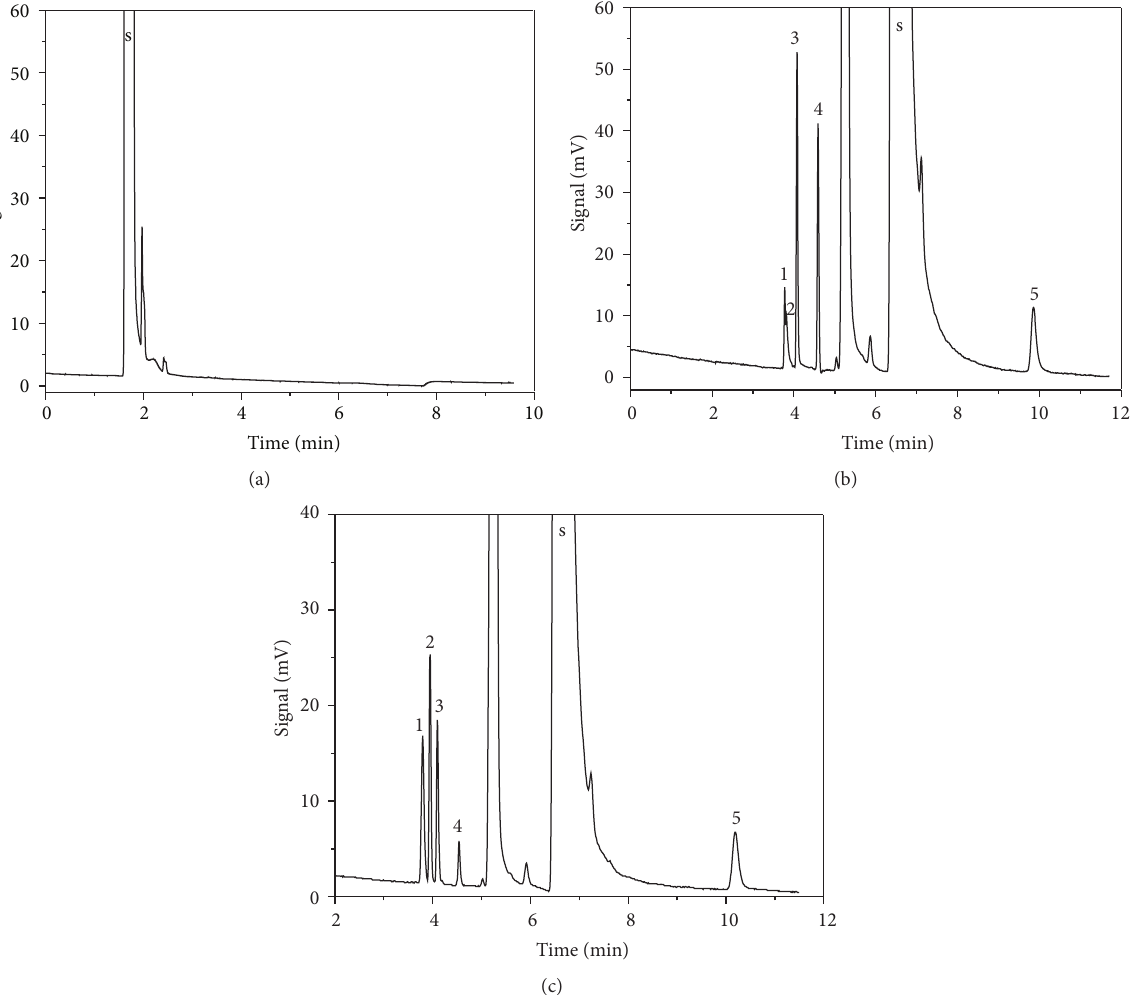
Figure 1: Typical chromatogram with different separation columns of SE-54 (a), PEG-20M (b) and alkali-modified PEG-20M (c). Peaks: solvent (s), dimethylamine ( 1 ), allyldimethylamine ( 2 ), allyl chloride ( 3 ), allyl aldehyde ( 4 ), and allyl alcohol ( 5